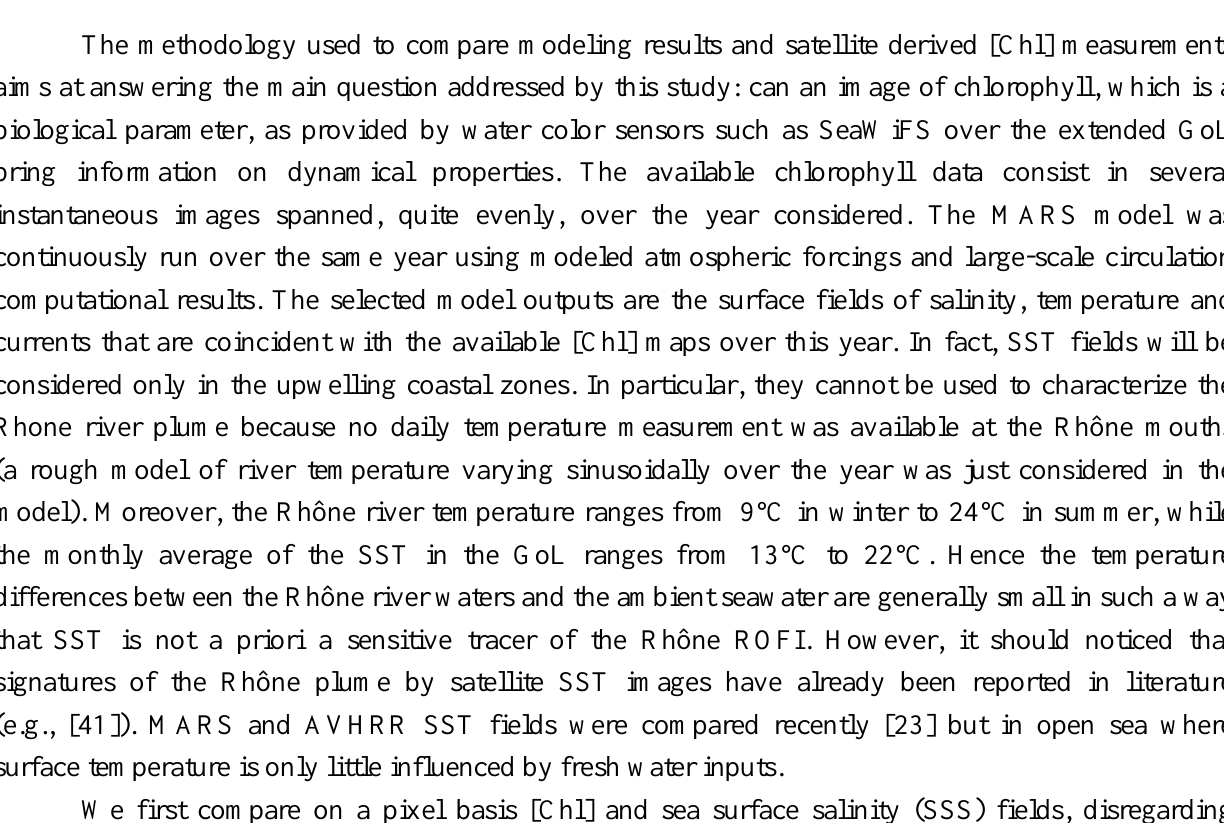
Figure 4. Selected coincident maps of MARS surface salinity and current and SeaWiFS chlorophyll concentration. The horizontal bar in the upper left corner corresponds to a surface current of 1 m s -1 . The white line draws the 130m isobath which corresponds to the shelf break of the